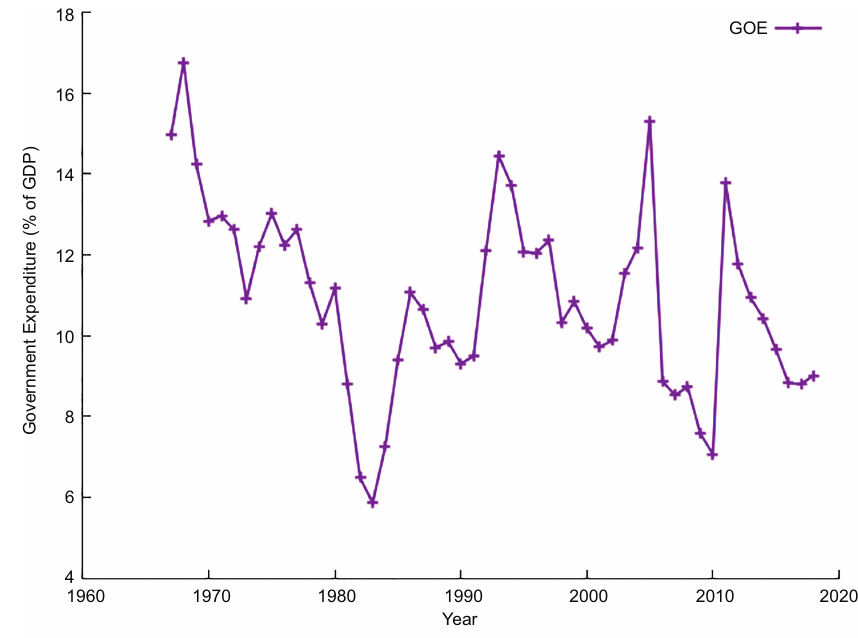
Figure 2. Trends in government expenditure in Ghana (% of